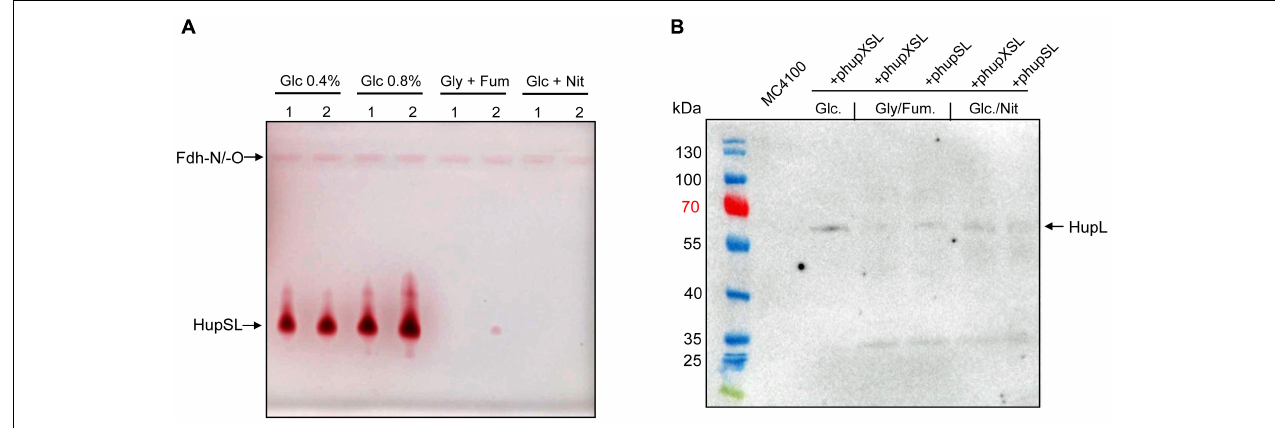
FIGURE 2 | Heterologous HupSL enzyme activity is only detectable in fermentatively growing E. coli cells. (A) Crude extracts derived from FTD147 ( (cid:49) hyaB (cid:49) hybC (cid:49) hycE ) transformed with plasmid phupXSL (1) or phupSL (2) after growth in M9 minimal medium with the indicated carbon sources were separated in native-PAGE and stained for hydrogenase enzyme activity, as described in the legend to Figure 1 . (B) A western blot using peptide antibodies raised against HupL (Hartwig et al., 2017) is shown in which the same extracts used in part A were separated in 10% (w/v) SDS-PAGE. The molecular mass marker proteins are presented in kDa. MC4100 was the wild type